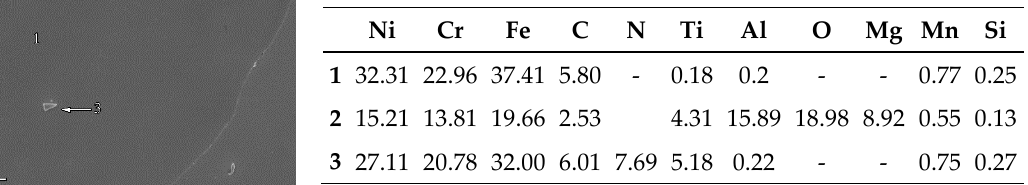
Figure 9. Compositions of precipitates in the GTAW welds of Alloy 52.